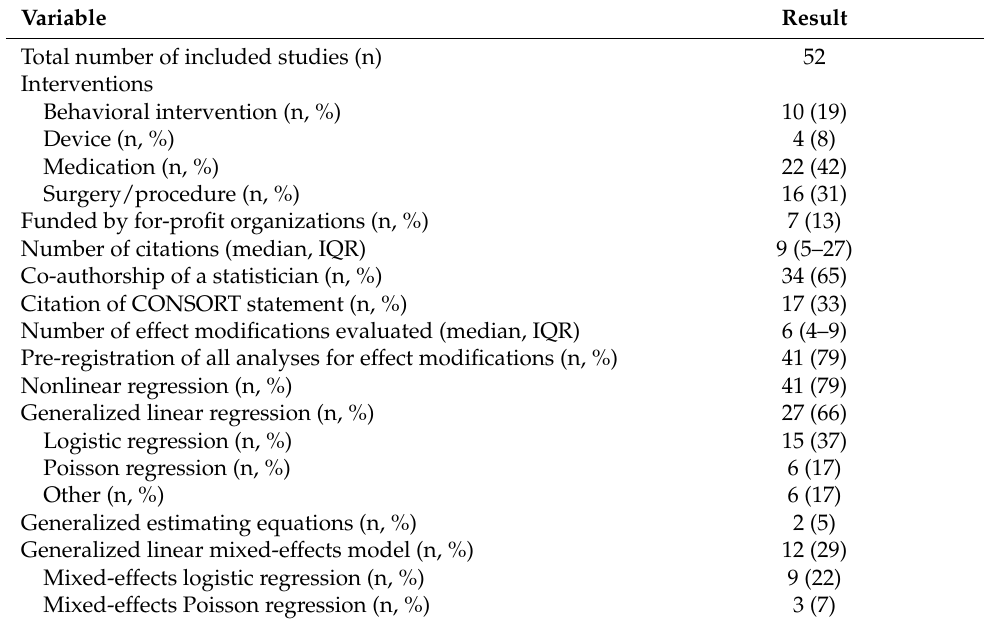
Figure 1. After screening 686 titles and abstracts and subsequently reviewing 578 full articles, we finally included 52 articles. The included and excluded articles are summarized in Supplementary Tables S4 and S5. Table 1. Study